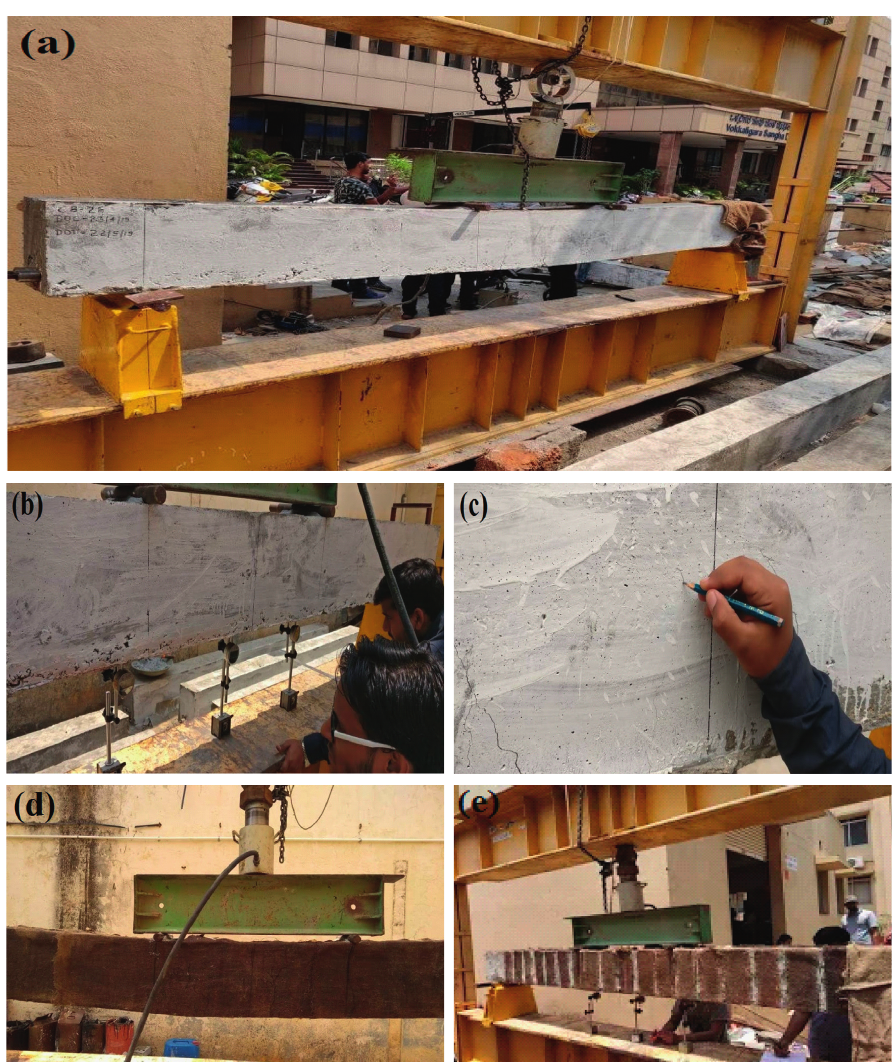
Figure 4: (a) Control beam placed on the loading frame. (b) Dial gauge measurements. (c) Crack on CB. (d) Jute fibre FW. (e) Jute fibre